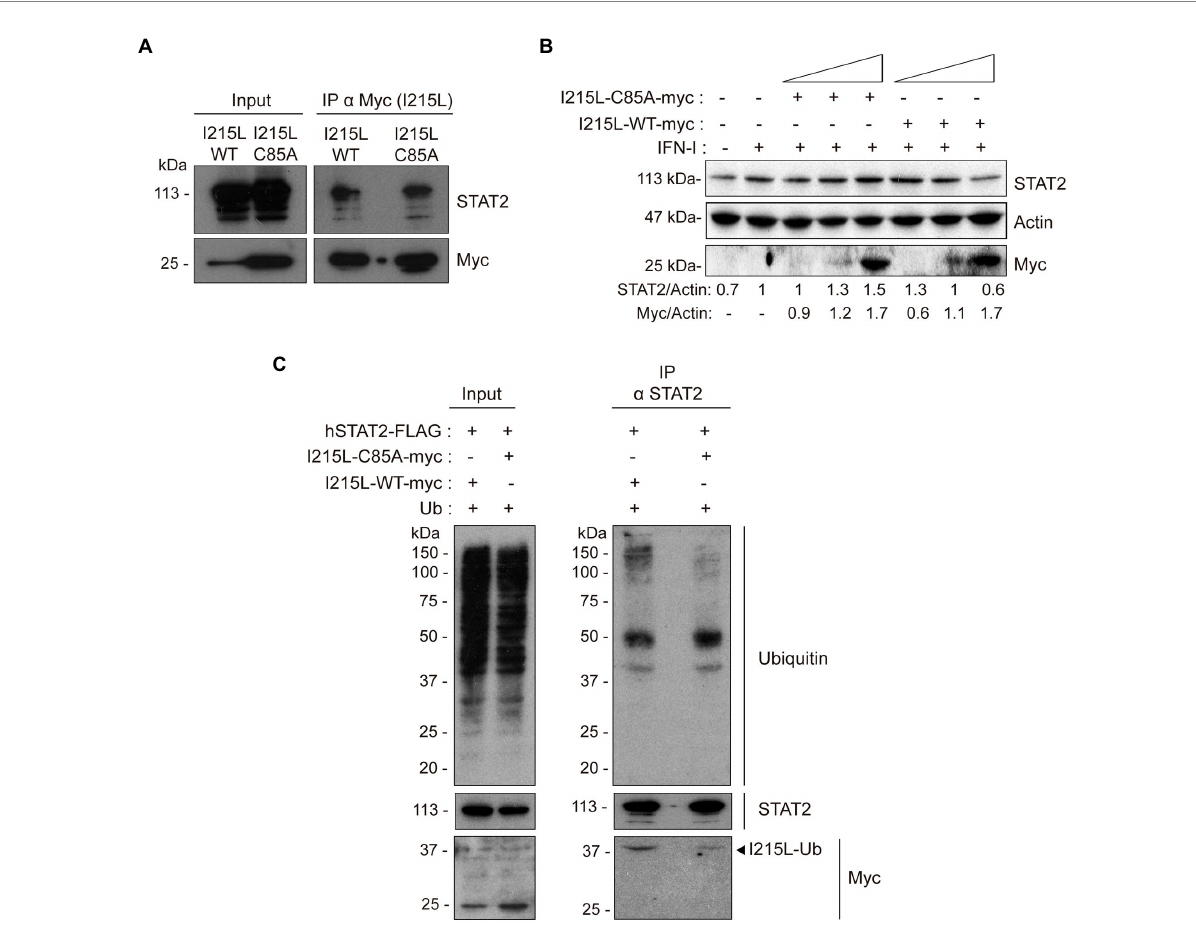
FIGURE 5 The ubiquitin-conjugating catalytic domain of I215L is not required for interaction with STAT2 but is required for its ubiquitination and degradation. (A) Immunoprecipitation of I215L-WT or I215L-C85A in BSRT7 cells co-transfected with hSTAT2-FLAG and with either pIRES-I215L-WT-myc or pIRES-I215L-C85A-myc, using an anti-myc antibody. BSRT7 cells were co-transfected with hSTAT2-FLAG (0.4 μ g/1 × 10 6 cells) and either pIRES- I215L-WT-myc or pIRES-I215L-C85A-myc (2 μ g/1 × 10 6 cells) plasmids. At 24 h post-transfection, cells were treated with IFN-I (500 U/mL) for 1 h. Then, cells were collected and lysed for immunoprecipitation assay with A/G magnetic beads using anti-myc antibody. Western blot labeling anti- STAT2, anti-myc and anti-actin antibodies is shown. (B) STAT2 levels were analyzed in presence of increasing concentrations of either I215L- C85A-myc or I215L-WT-myc protein (0.25, 1, or 2.5 μ g/1 × 10 6 cells) or EV (2.5 μ g/1 × 10 6 cells) in HEK-293 by Western blot assay. Antibodies against STAT2, myc and actin were used. STAT2 and pI215L-myc levels were quantified according with their actin levels and relativized with the EV control using ImageJ. (C) Immunoprecipitation of STAT2 in Vero cells transfected with either pIRES-I215L-WT-myc or pIRES-I215L-C85A-myc. Vero cells were co-transfected with pCI-His-hUbiquitin (1 μ g/1 × 10 6 cells), hSTAT2-FLAG (0.4 μ g/1 × 10 6 cells) and either pIRES-I215L-WT-myc or pIRES-I215L- C85A-myc (2 μ g/1 × 10 6 cells) plasmids. At 24 h post-transfection, cells were treated with IFN-I (500 U/mL) for 2 h. Cells were collected and lysed for STAT2 immunoprecipitation assay with A/G magnetic beads. Western blot labeling with anti-ubiquitin, anti-STAT2, anti-myc, and anti-actin antibodies is